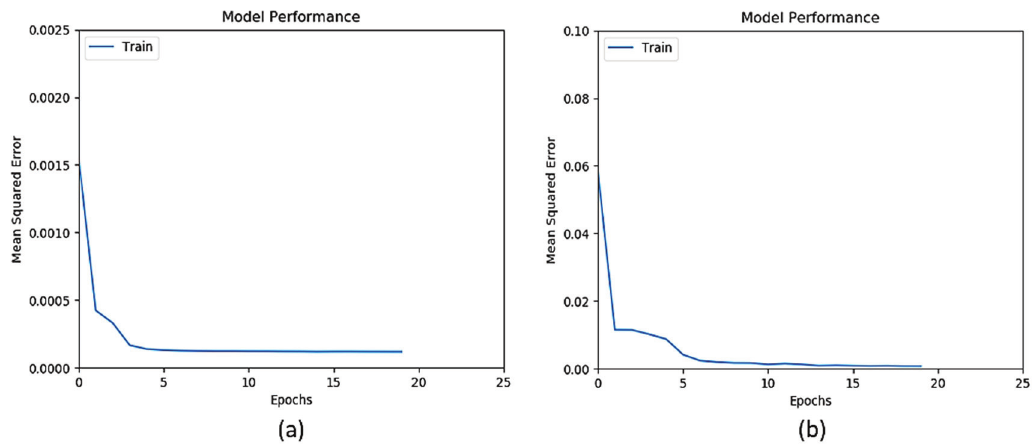
Figure 4. Mean Squared Error vs. Epochs for ( a ) EnviroCar, and ( b ) air quality index (AQI).